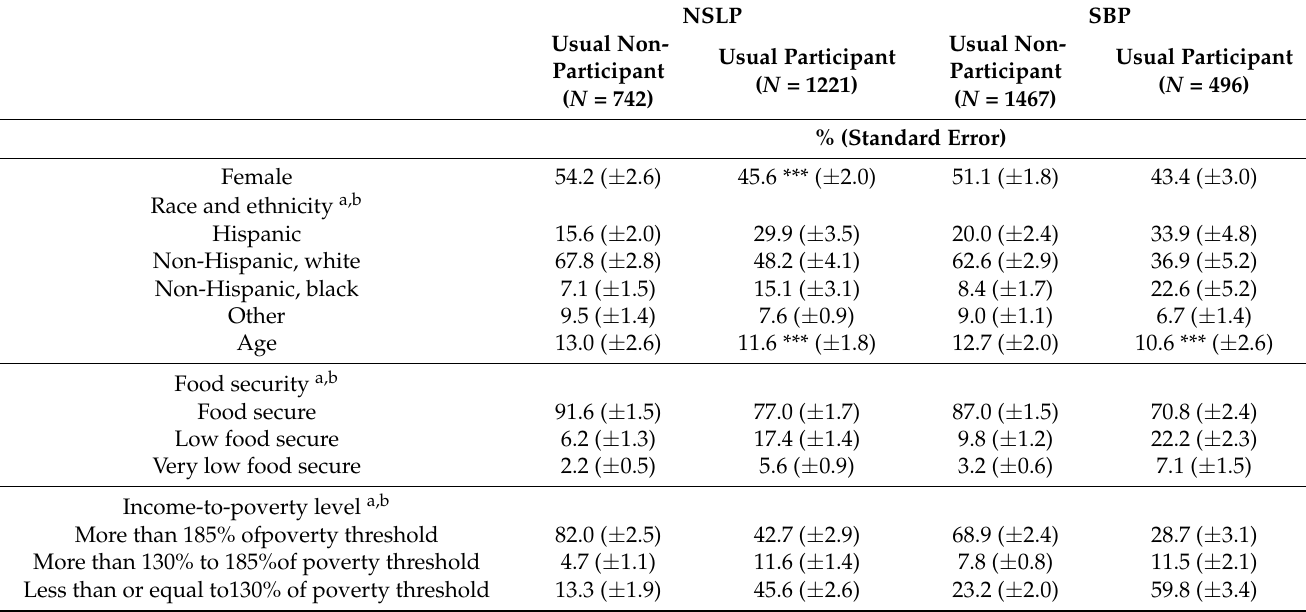
Table 2. Characteristics of students, by National School Lunch Program (NSLP) and SBP usual participation status.